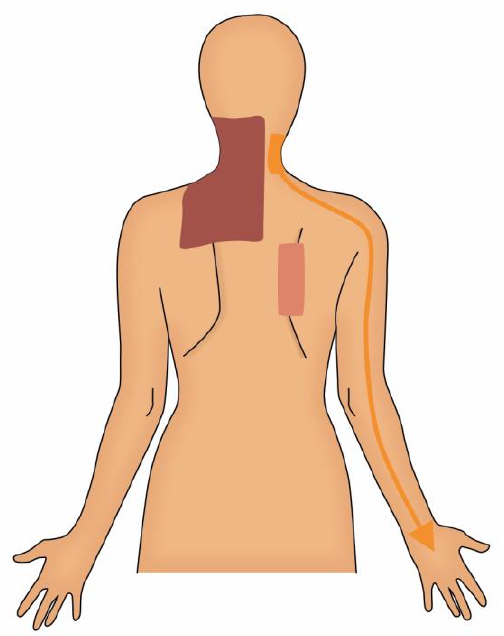
Figure 2. Pain Sources, Posterior View. Brown: Myofascial Pain; Orange: Cervical Radiculopathy; Pink: Scapulothoracic Bursitis.